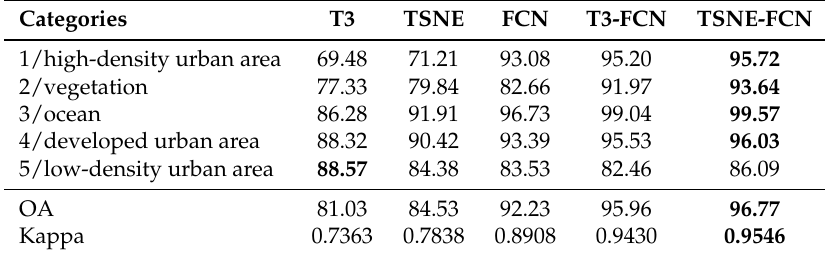
Table 3. Category accuracy (%), OA (%) and kappa coefficient of different features (classifier: SVM) on San Francisco dataset. (The category with highest accuracy is shown in bold.)